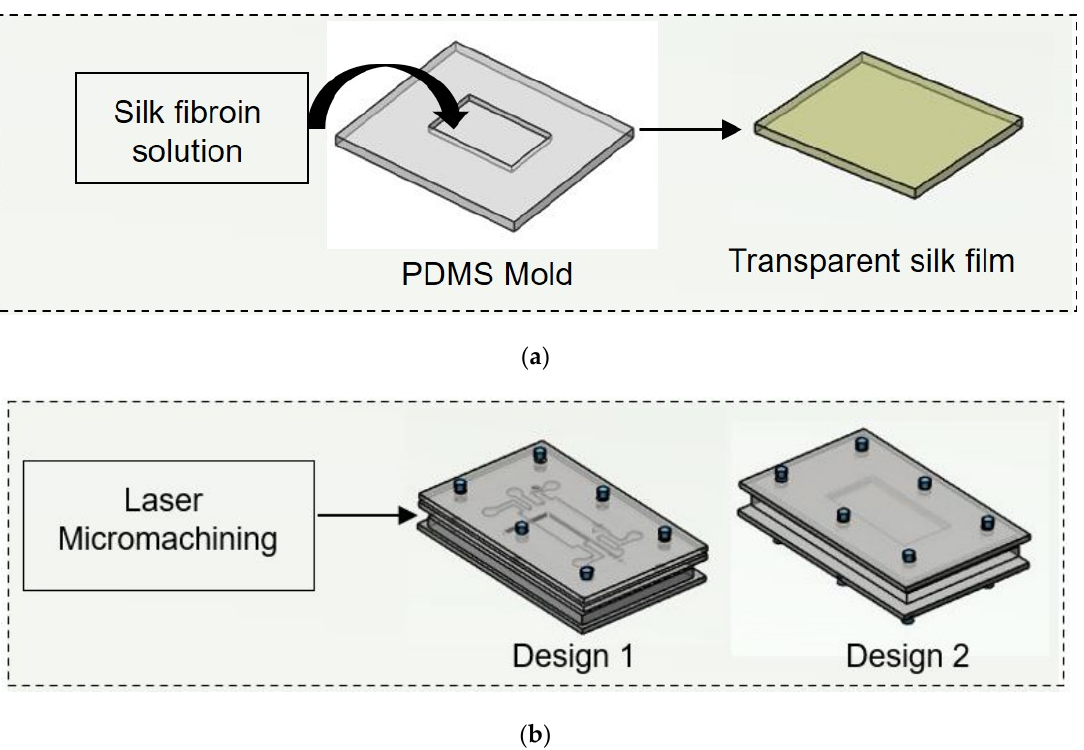
Figure 2. Schematic illustration of experimental procedure carried out. ( a ) Initially nonmulberry silk fibroin was added to PDMS mold to prepare transparent film. ( b ) Two chips were fabricated using laser micromachining.